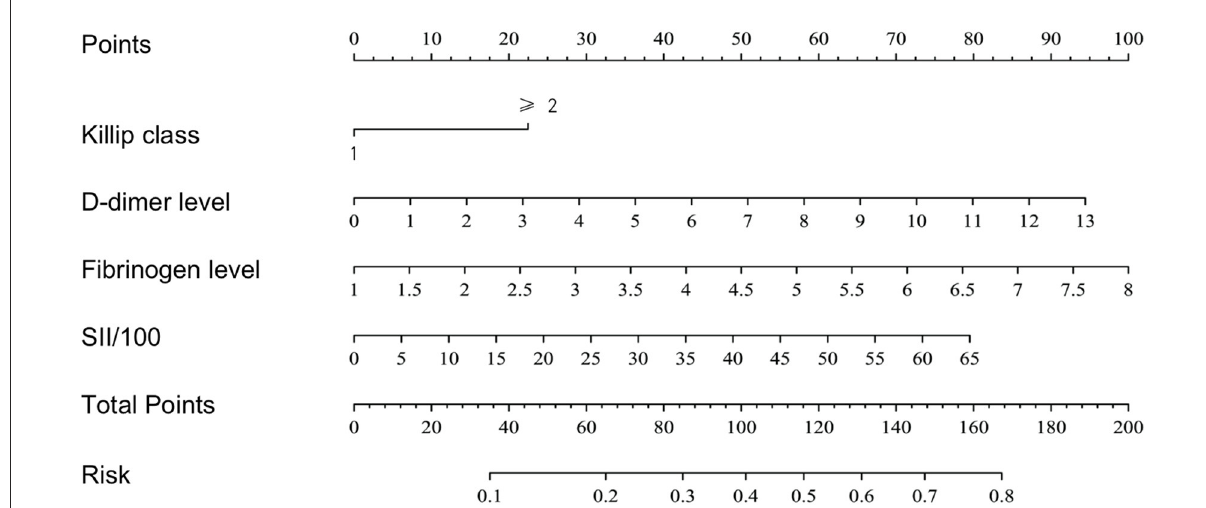
FIGURE2 The nomogram model for predicting the risk of no-reflow after PCI in STEMI patients.